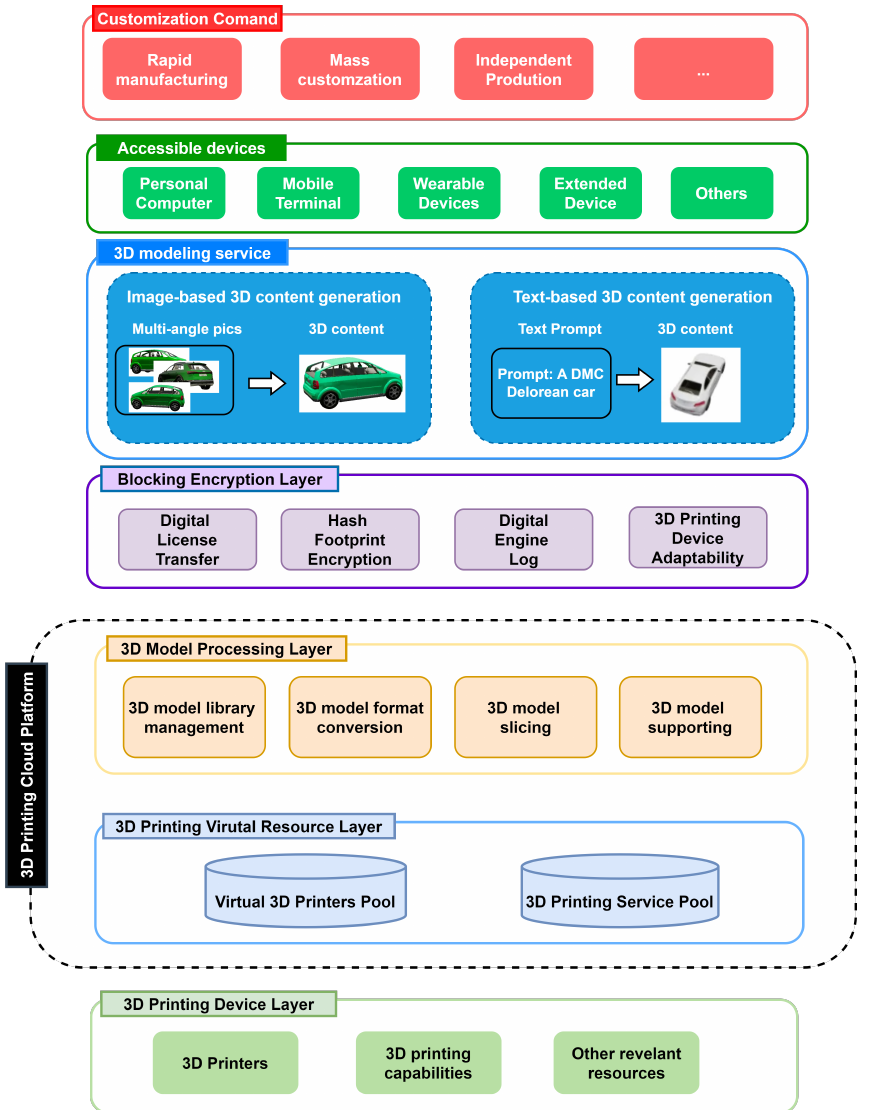
Figure 2. The Efficient Product Customization